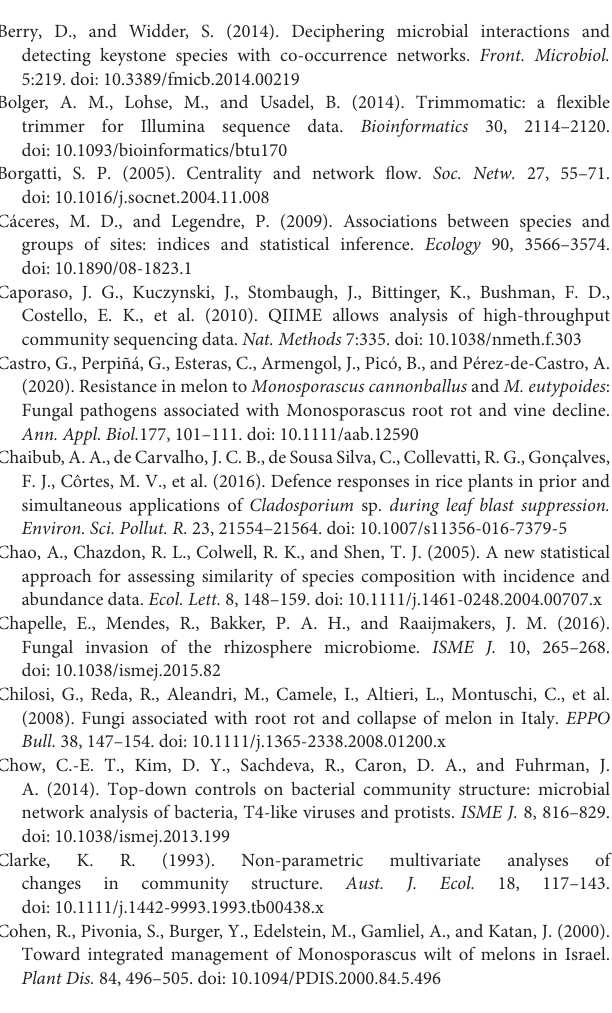
Supplementary Figure 1 | Rarefaction curves depicting the effect of total number of sequences sampled on the number of OTUs identified from the roots and rhizosphere of three watermelon cultivars (HT, roots of highly resistant cultivar; MT, roots of moderately resistant cultivar; ST, roots of susceptible cultivar; HR, rhizosphere of highly resistant cultivar; MR, rhizosphere of moderately resistant cultivar; SR, rhizosphere of susceptible